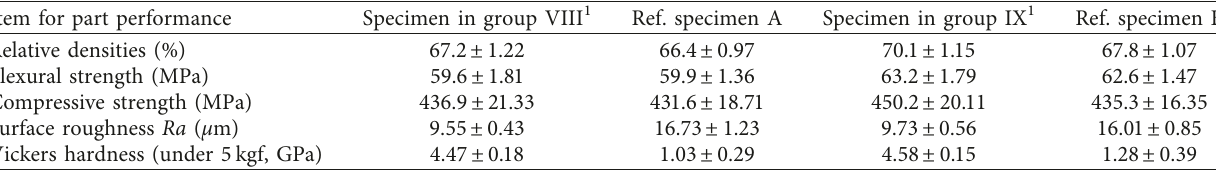
Figure 19: Variations of final-sintered specimens’ mechanical strength along with their final densities. (a) Flexural strength. (b) Com- pressive Table 6: Comparison of final part performances between the integrated processing specimens in Groups VIII and IX and the corresponding reference specimens A and B postprocessed just by sintering.